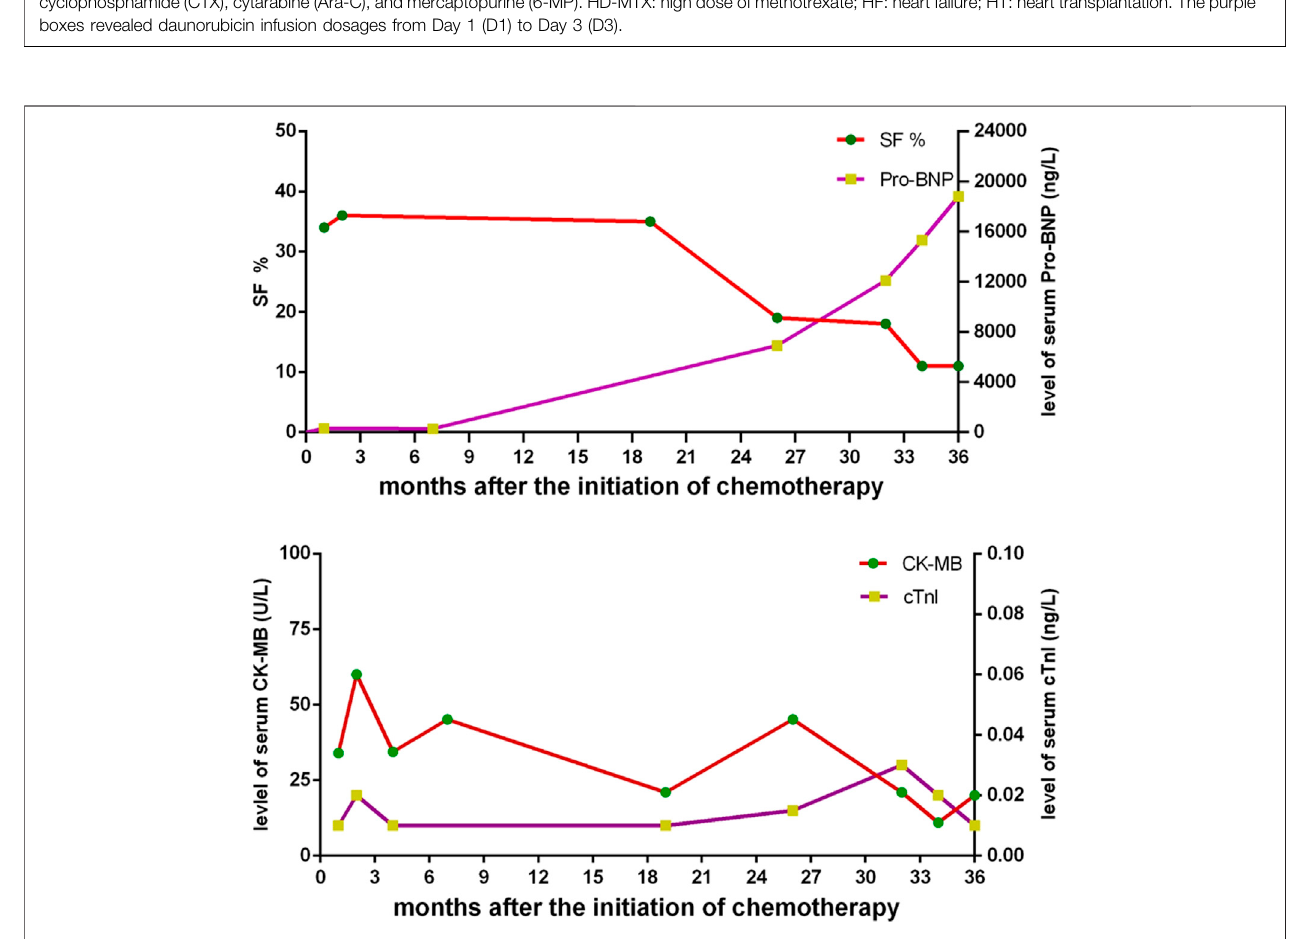
FIGURE2| Thechangesofshorteningfraction(SF),serumproBtypenatriureticpeptide(Pro-BNP),creatinekinase(CK-MB),andcardiactroponinI(cTnI)afterthe outset of chemotherapy.